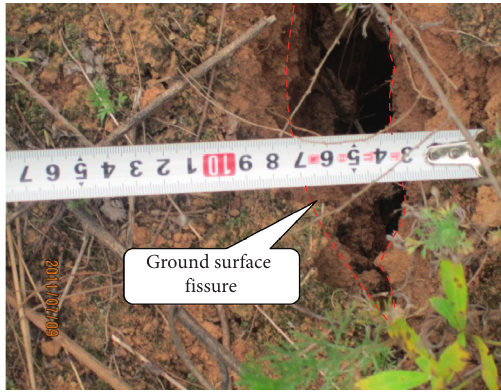
Figure 9: Ground surface fissure.